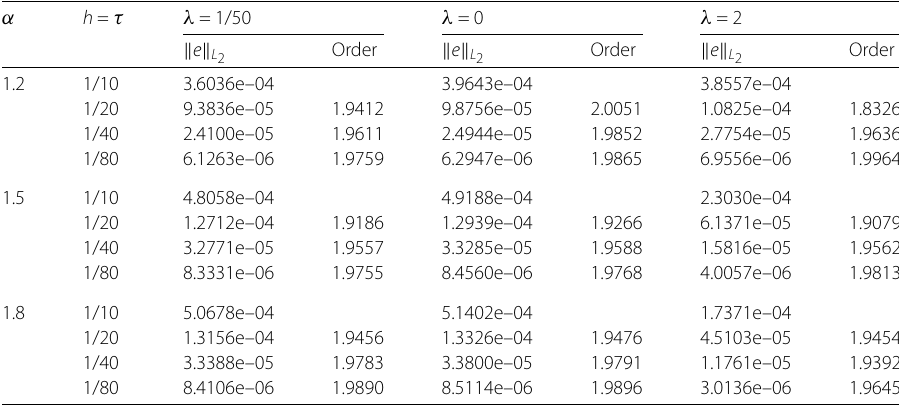
Table 10 Errors and corresponding observation orders at t = 1, γ 3 = 0